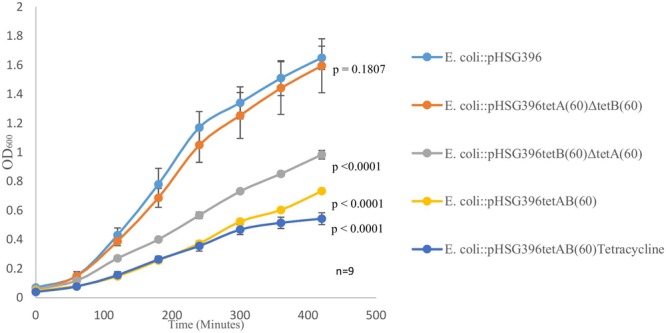
The above graph depicts growth curves for E. coli::pHSG396, E. coli::pHSG396tetB(60)ΔtetA(60) and E. coli::pHSG396tetA(60)ΔtetB(60) grown in LB and chloramphenicol for 7 h. It also shows the growth curve for E. coli::pHSG396tetAB(60) grown in LB and chloramphenicol with and without tetracycline to determine how the antibiotic effected the clone’s growth. P-values for OD600 at 7 h were calculated from biological triplicate OD600 measurements at 420 min for each clone compered to E. coli::pHSG396 are indicated beside each growth curve.